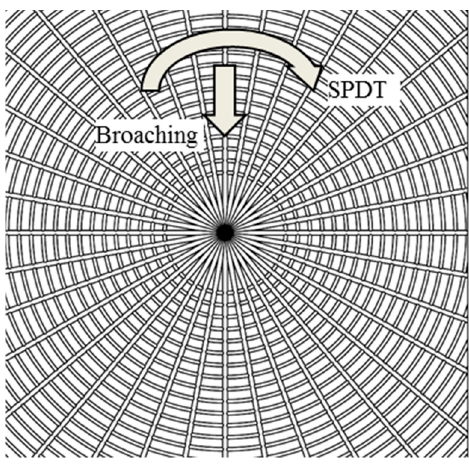
Figure 6. MPC3 (Combining SPDT and diamond broaching process) of machining polar microstructure.